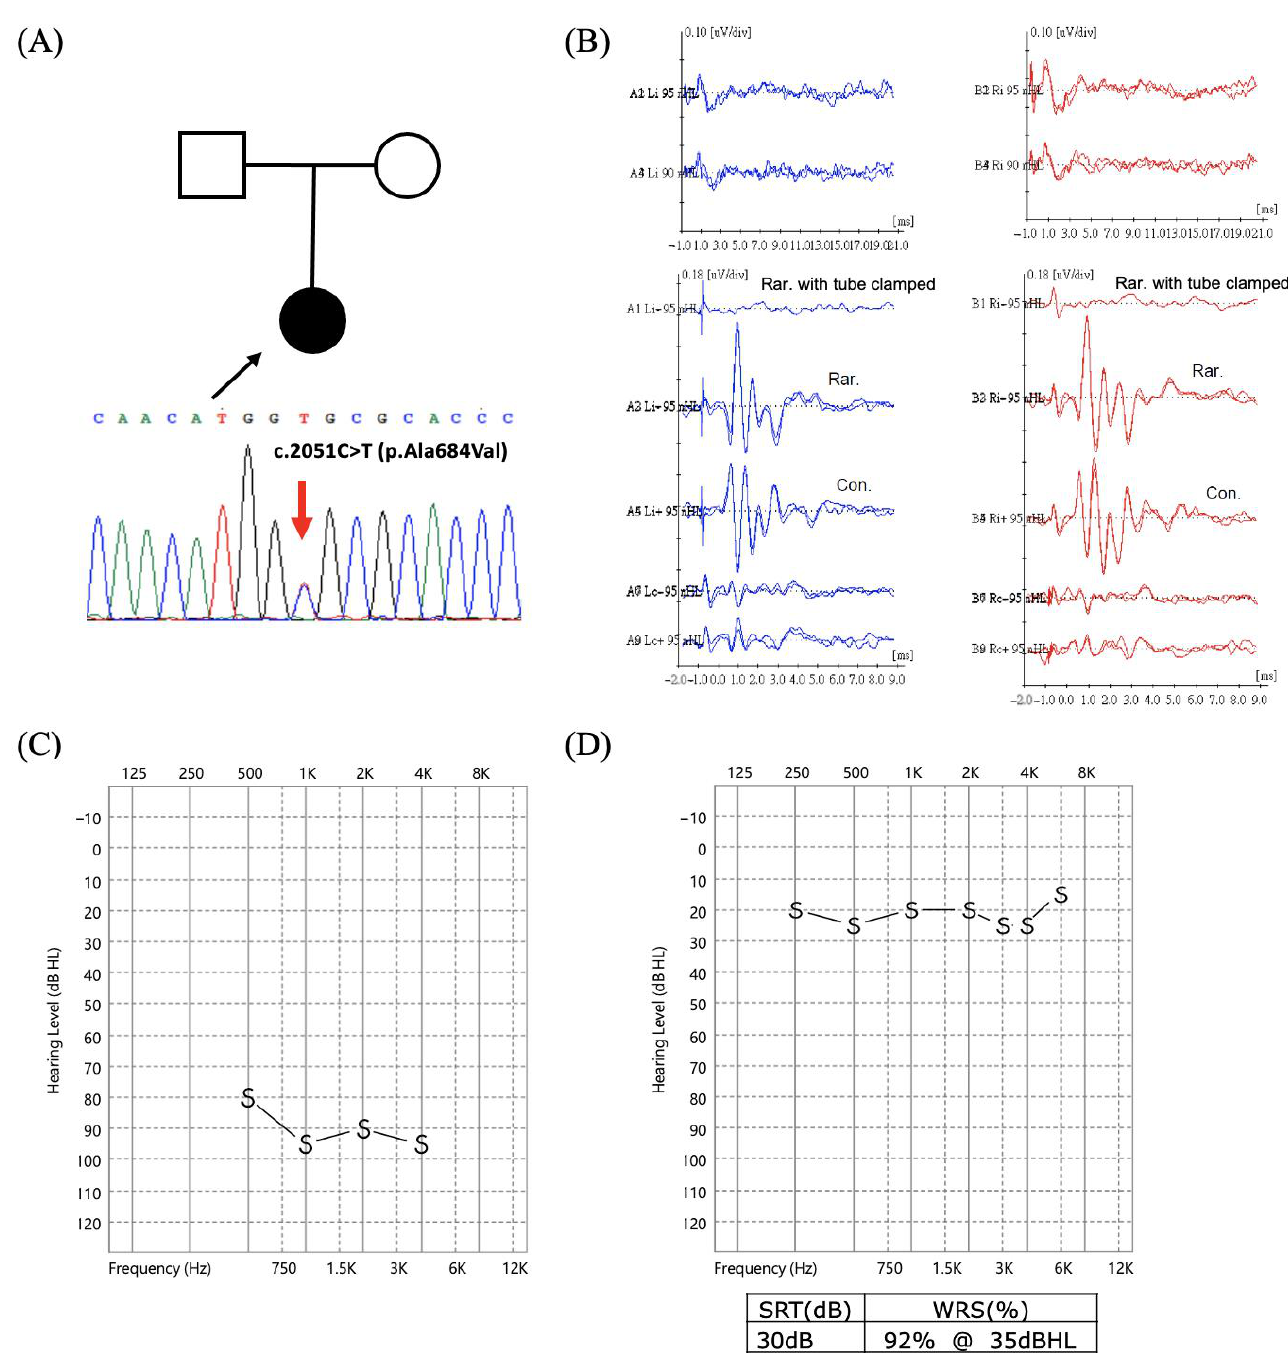
Figure 1. Cochlear implantation outcome in a patient with WFS1 c.[2051C>T];[2051=]. ( A ) The heterozygous WFS1 c.2051C>T (p.A684V) variant identified in the proband. ( B ) Cochlear microphonics were recoded despite no wave V identified at 95 dBnHL on auditory brainstem response examinations bilaterally, showing the typical presentation of auditory neuropathy spectrum disorder. ( C ) Preoperative behavioral audiometry reveals profound sensorineural hearing loss with a hearing threshold of approximately 90 dBHL. ( D ) Postoperative behavioral and speech audiometry show ideal cochlear implant-aided hearing threshold and good speech perception. Abbreviations: Con, condensation; Rar, rarefaction; SRT, speech recognition threshold; WRS, word recognition score. A patient with the OPA1 c.1414T>C (p.C472R) variant presented with slowly pro- gressive hearing loss that deteriorated to moderate-to-severe SNHL in her teens (Figure 2B). However, the speech recognition deteriorated rapidly (WRS = 12 – 16%). The patient